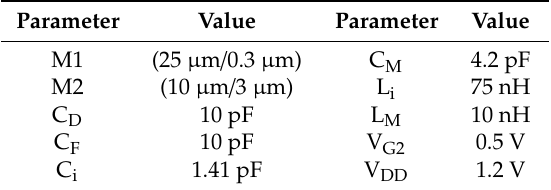
Table 1. Summary of component values for the MOSFET-based envelope detector with transformer.